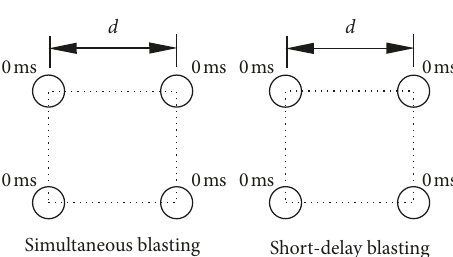
Figure 2: Delay schemes of blasts with four blast holes. (a) Si- multaneous blasting. (b) Short-delay blasting.